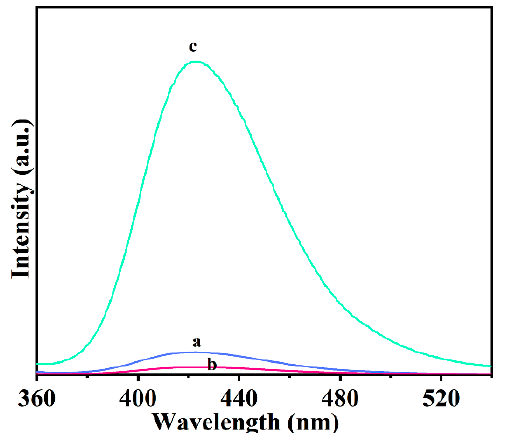
Figure 7. Photoluminescence spectra of UCNPs ( a ), R-TiO 2 ( b ), and UCNPs@R-TiO 2 nanocomposite ( c ), respectively, measured under 980 nm NIR illumination for 20 min.